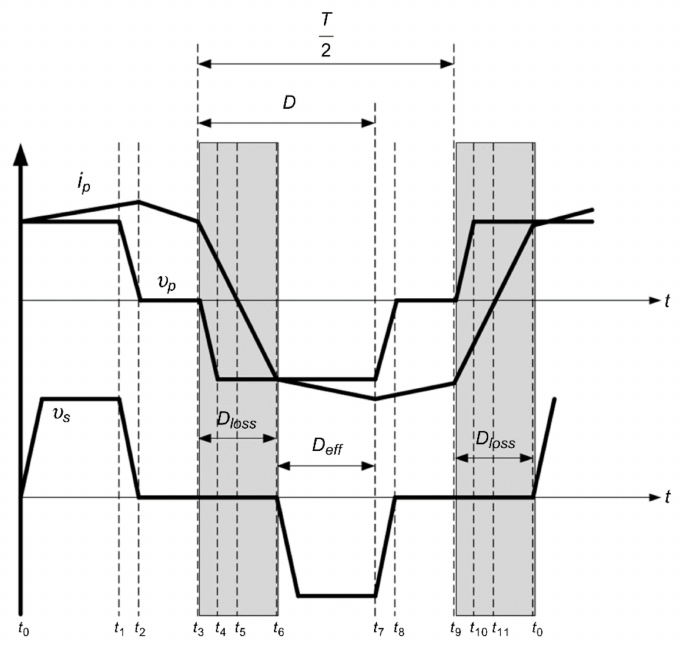
Figure 9. Key waveforms of transformer and illustration of duty cycle.